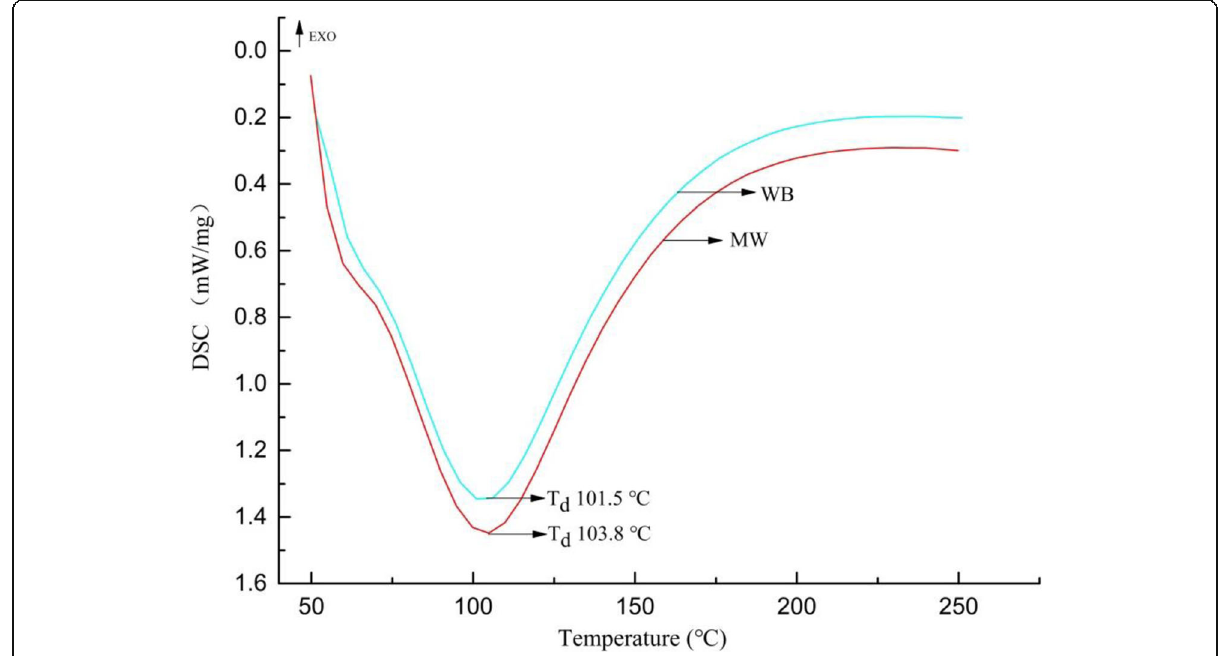
Fig. 4 The denaturation process of hide powder tanned by chrome tanning liquor treated by different method